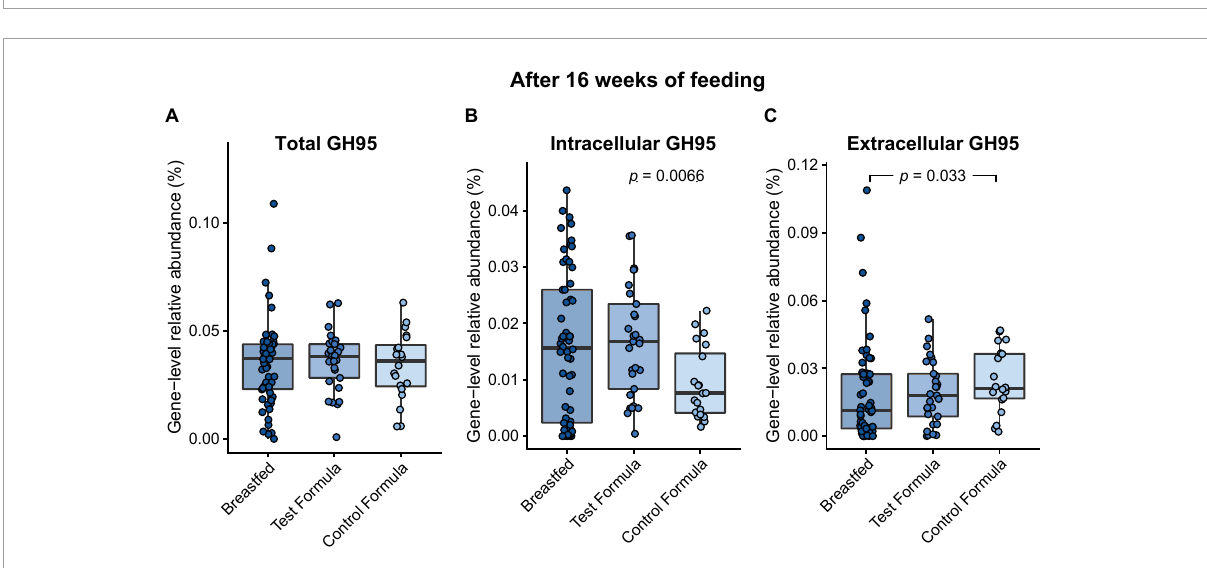
FIGURE4 Box plots of the relative gene-level abundance of GH95 after 16 weeks of feeding in infants in the three feeding groups: breastfed, test formula, and control formula. Comparisons between the feeding groups were carried out for total GH95 (A) , GH95 encoding a signal peptide corresponding to the external strategy (C) , and GH95 which did not encode a signal peptide (B) . Horizontal lines indicate the median; box boundaries indicate the interquartile range; whiskers represent values within 1.5 × the interquartile range of the first and third quartiles. Statistics: Mann–Whitney U -test. P -values < 0.05 are